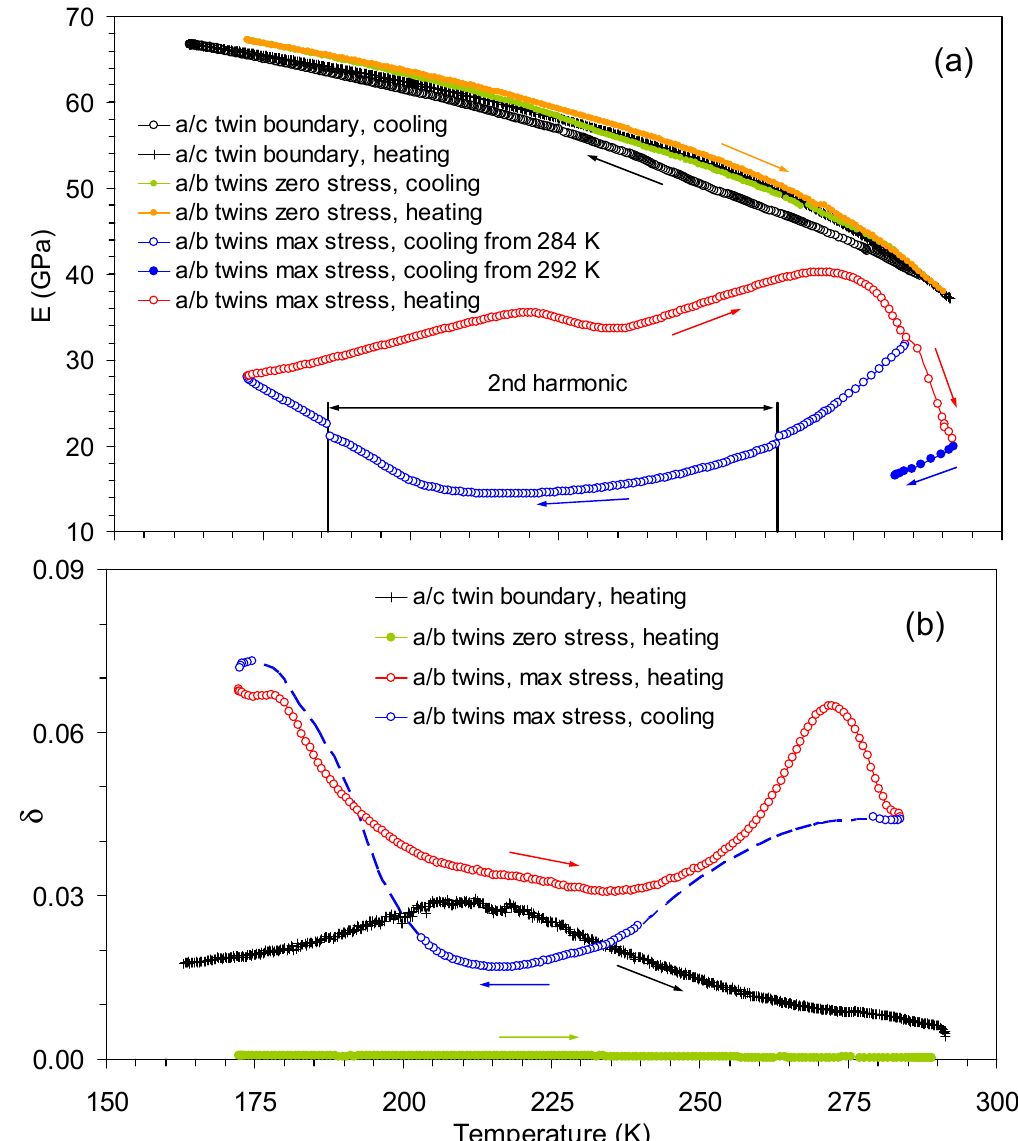
Figure 9. Temperature spectra of the Young’s modulus ( a ) and internal friction ( b ) for the samples with three types of a/c and a/b twin structures shown in Figure 1. Cooling and heating scans at 2K/min are shown in ( a ) and in ( b ) for the Structure 3 sample with maximum shear stress in the a/b twinning planes. For clarity, only heating scans are shown in ( b ) for the Structure 1 sample with a/c twin boundaries and Structure 2 sample (zero a/b shear stress), for which the thermal hysteresis is not significant. Note that the data for the Structures 2 and 3 (with zero and maximum a/b shear stress) correspond to the same sample with a/b twin structure reoriented by magnetic field, see [33] for the details of a/b twin structure modification. Broken parts of the temperature spectrum on cooling for the sample Structure 3 (maximum shear stress for a/b twins) mark the ranges where the damping values cannot be determined correctly due to the change of the oscillation harmonic (see text for details).